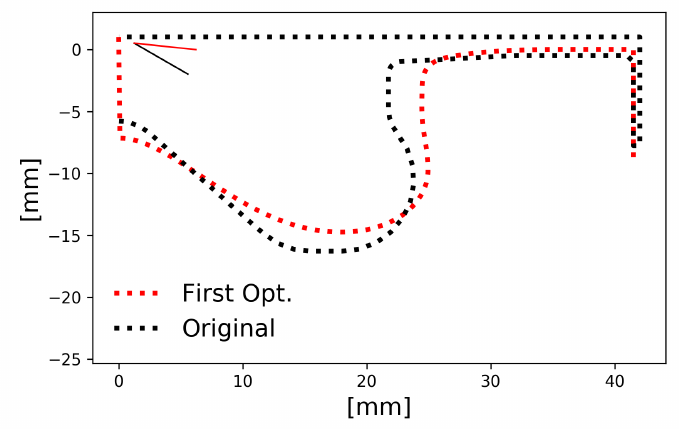
Figure 12. Original diesel bowl and optimum of the first